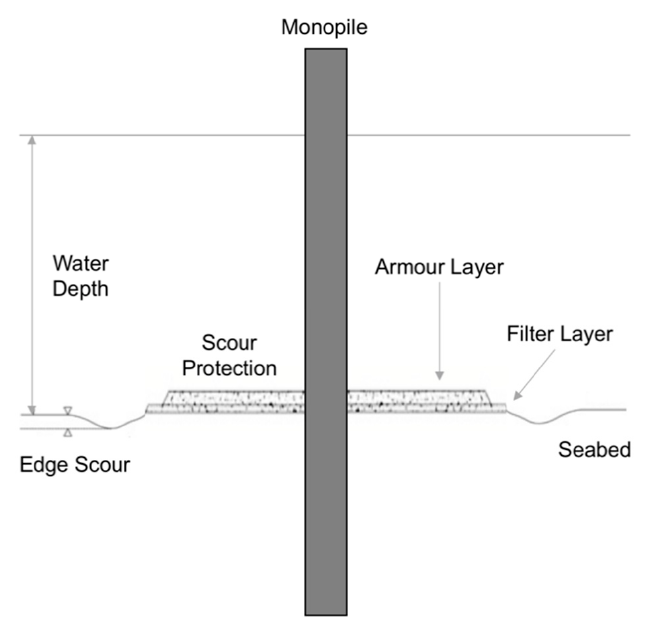
Figure 1. Illustration of a common scour protection design, modified from Whitehouse et al. [38]: Scour protection around an o ff shore wind turbine, laid on the seafloor. The vertical bar represents the monopile that holds the windmill rotor and turbine. The scour protection includes a preinstalled filter layer of small-sized rocks (e.g., 5 cm in diameter) covered by an armour layer of larger rocks (e.g., 40 cm in diameter). The filter layer prevents erosion of sand through the upper layer of larger rocks. The filter layer is usually about 0.5 m high, whereas the armour layer is about 1 m high. Edge scour (e.g., 0.5 m deep) may develop in the periphery of the scour protection. Further details on scour protection designs are provided by Whitehouse et al. [38]. In the present review, the foundation is defined as the monopile and the surrounding scour protection, as illustrated in the figure.